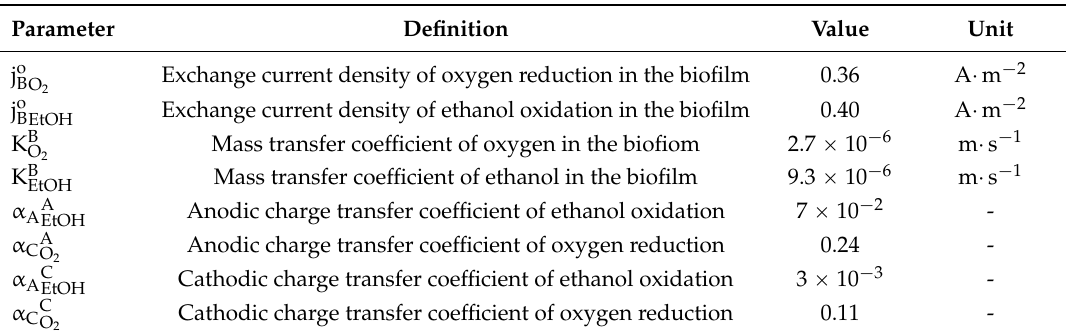
Table 1. Estimated kinetic and mass transfer parameters of the ethanol-air